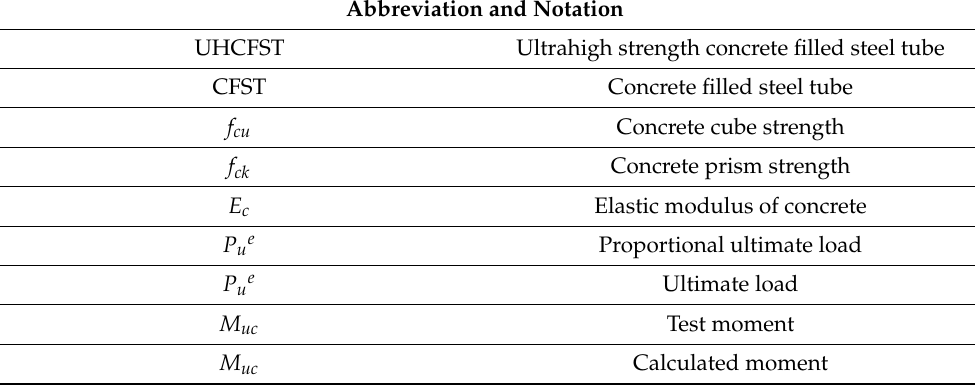
Table 1. List of abbreviations and